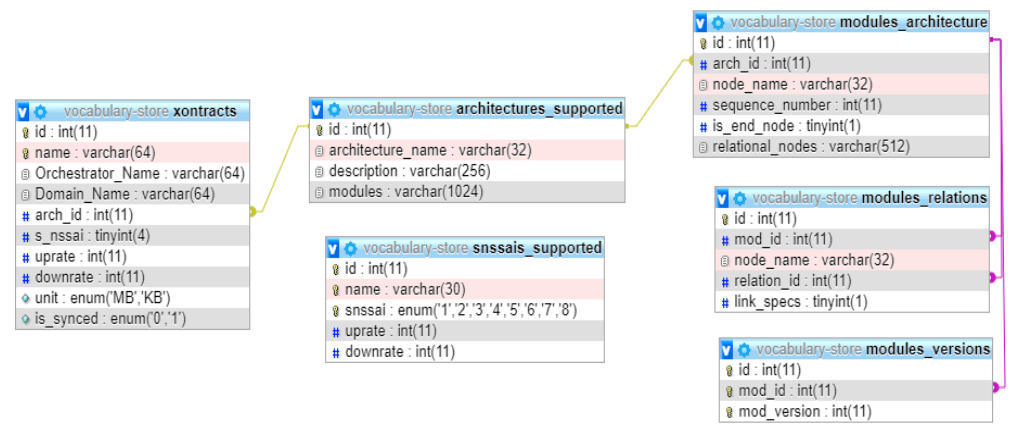
Figure 5. Design of the policy store